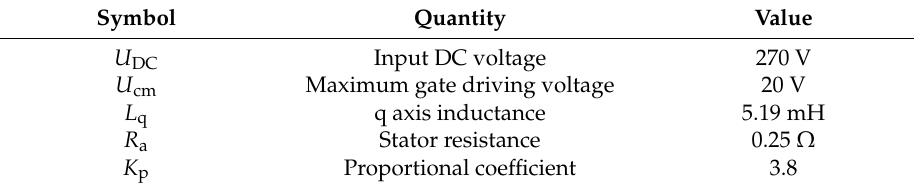
Table 2. The main parameters of the PMSM drive system.